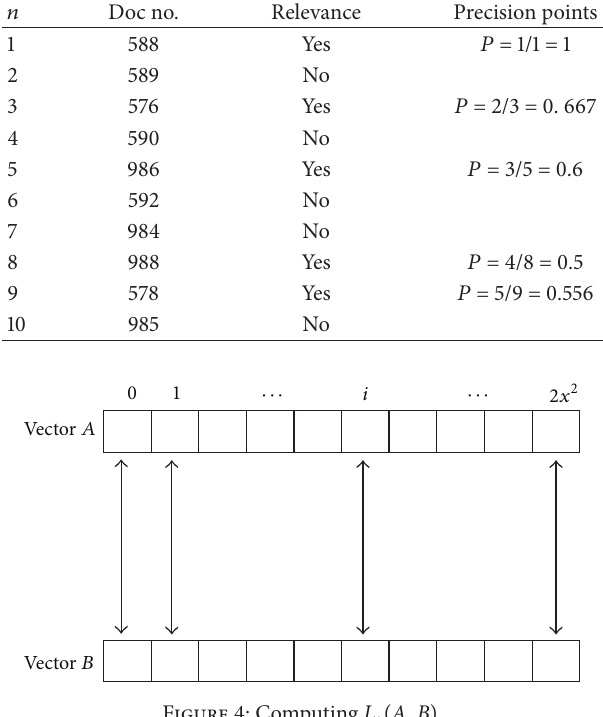
Figure 4: Computing L 1 ( A, B